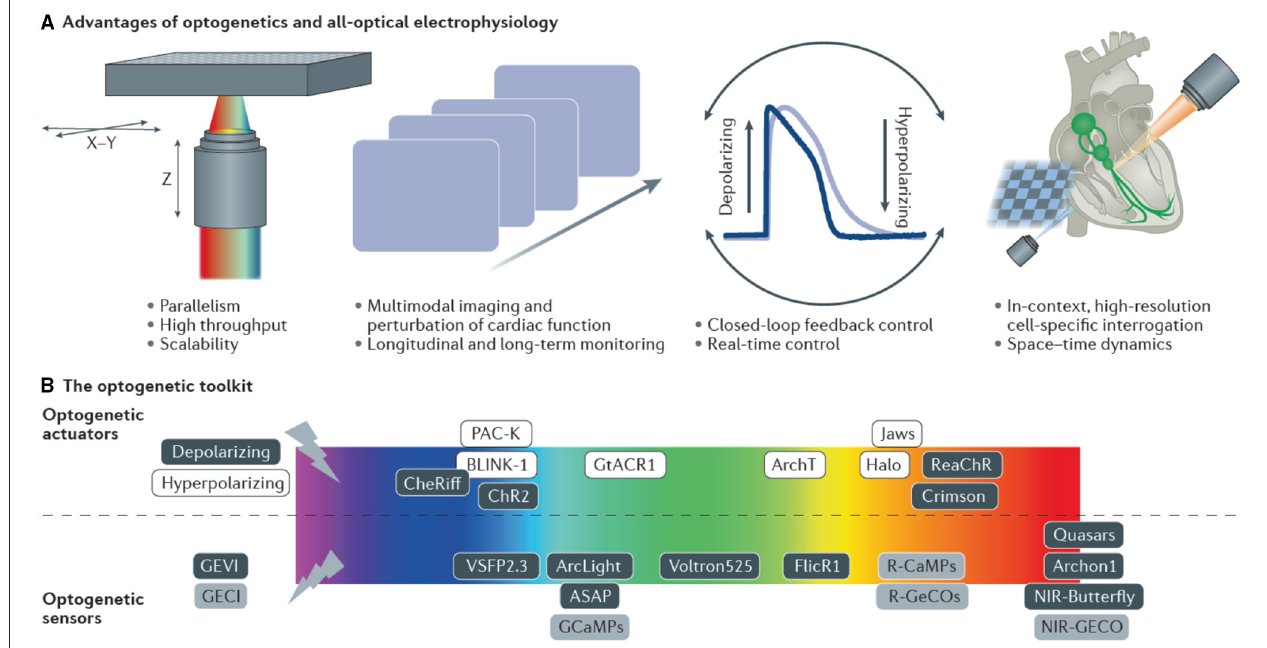
FIGURE 5 | All-optical cardiac electrophysiology and the toolkit of optogenetic actuators and reporters. (A) Advantages of all-optical cardiac electrophysiology using optogenetic tools. (B) Spectral compatibility of optogenetic actuators and reporters for voltage (GEVI) and calcium (GECI) with the possibility for bi-directional control (depolarization and hyperpolarization) of cardiac excitation. Reproduced with permission from Entcheva and Kay (2021).